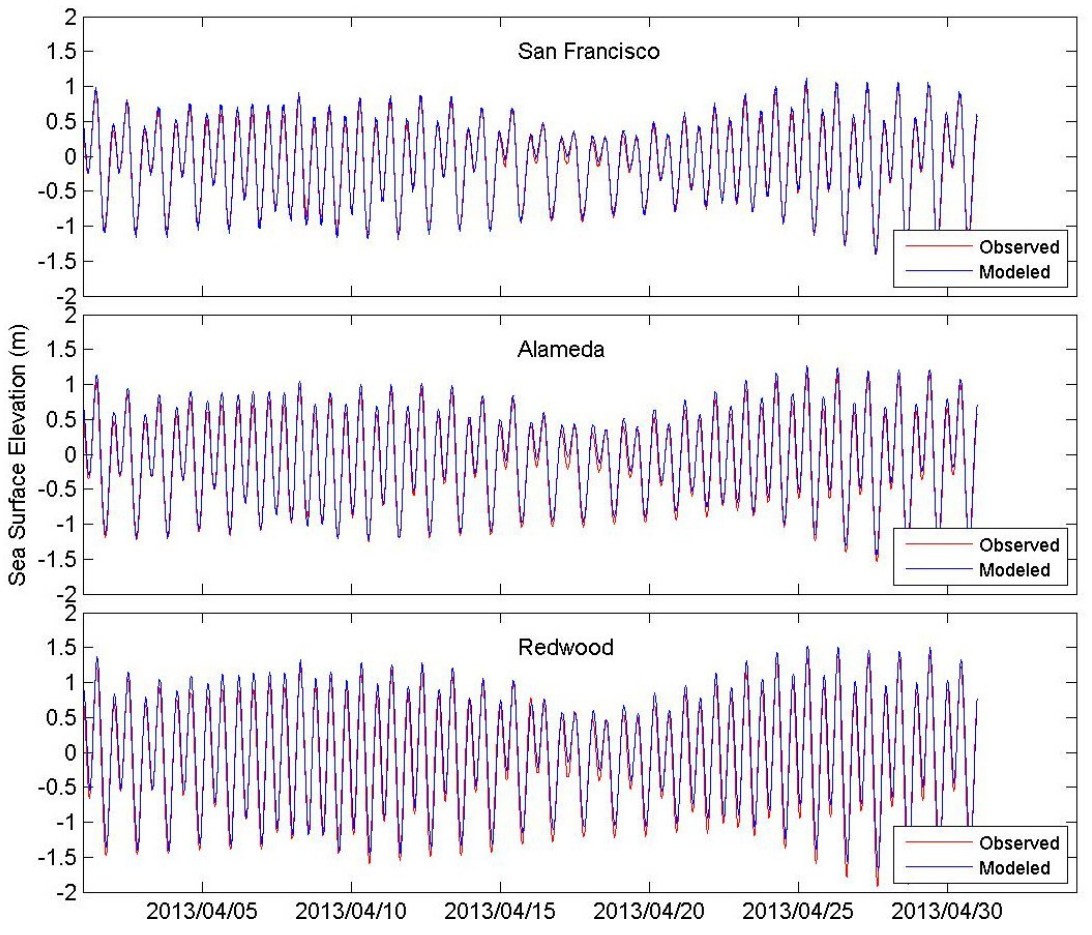
Figure 8. The comparison of modeled versus observed sea levels at three stations in April 2013. The station locations can be found in Figure